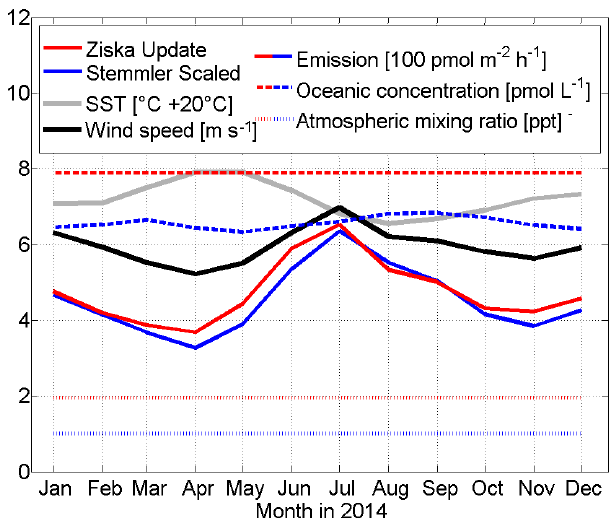
Figure 1. Annual cycle of monthly mean emissions, surface wa- ter concentrations, and atmospheric mixing ratios of bromoform, as well as monthly mean surface wind speed and SST in the IO/WP release area in 2014 for the two